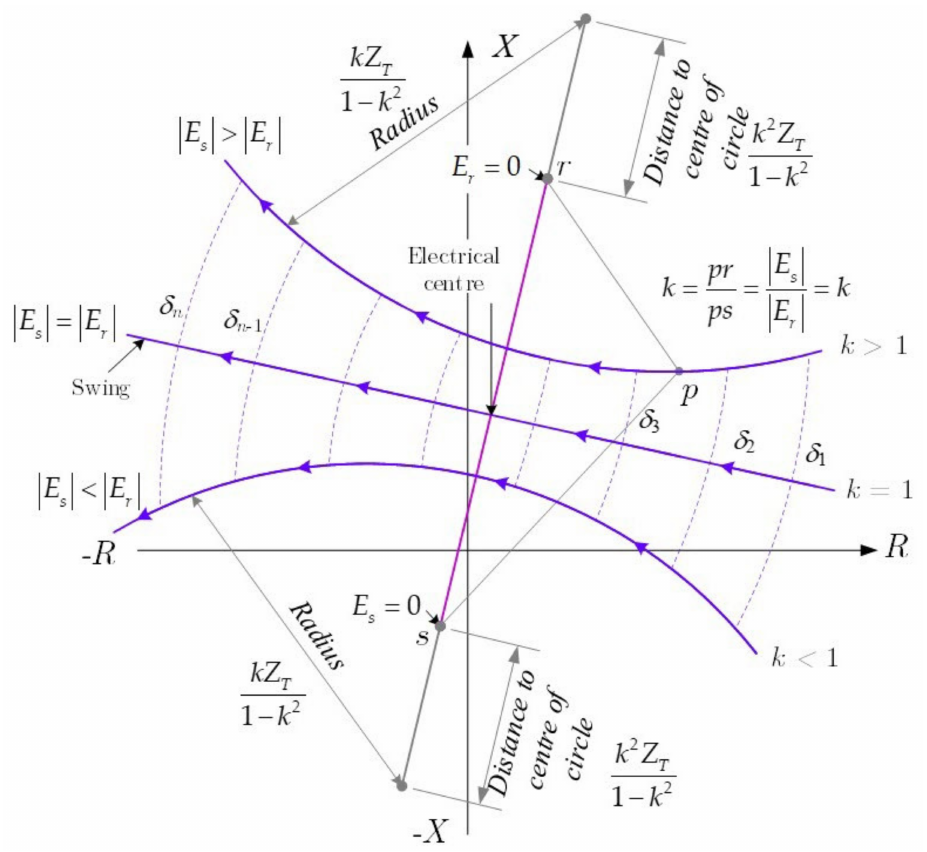
Figure 3. Typical impedance loci as “seen” by relay R s in Figure 1 during power swing. During the power system’s operation, the system’s electrical centres vary as the system impedances behind the line terminals and the equivalent internal generator voltages